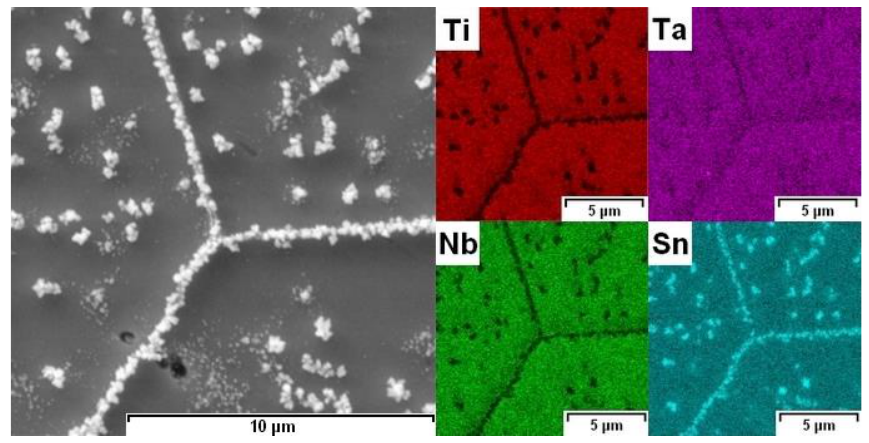
Figure 6. Elemental mapping images of SPS sample (SEM – EDS).